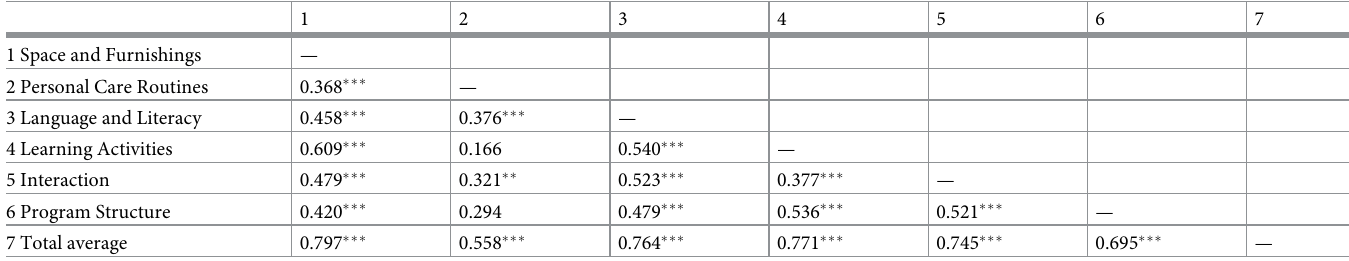
Table 5. Correlations among the subscale scores and the total